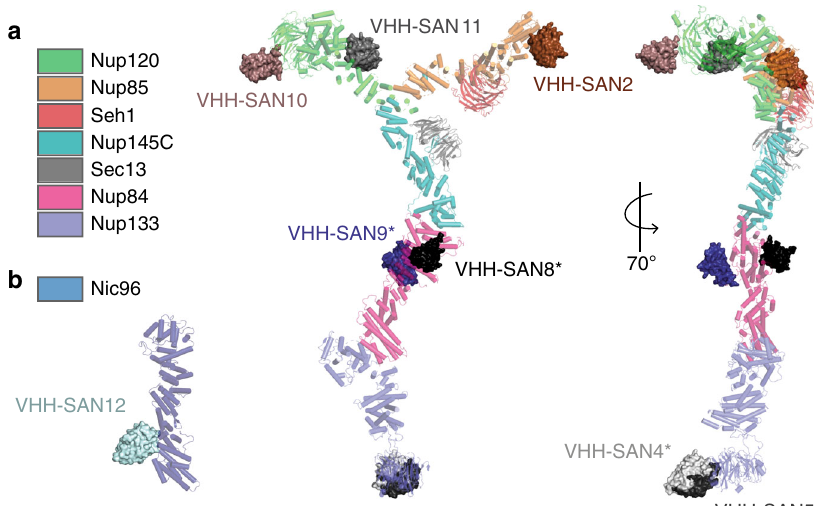
Fig. 3 Structures of nanobodies complexed to the Y complex and Nic96. a Structures of nanobody-nup complexes docked onto the composite structure of the Y complex. Nanobodies are shown as surfaces, the Y complex is shown as cartoon. VHH-SAN10/11 was solved in complex with Nup120 1 – 757 . VHH- SAN2 was solved in complex with Nup85-Seh1 1 – 564. *Indicates structures described in ref. 20 . b Structure of Nic96 in complex with